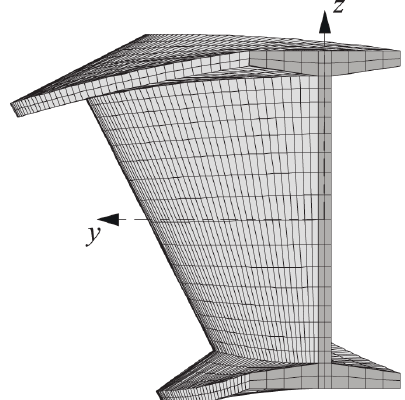
Figure 3. FE model in the Ansys program for the analysis of LTB – view in the y-z plane 57×58 mm (300×300